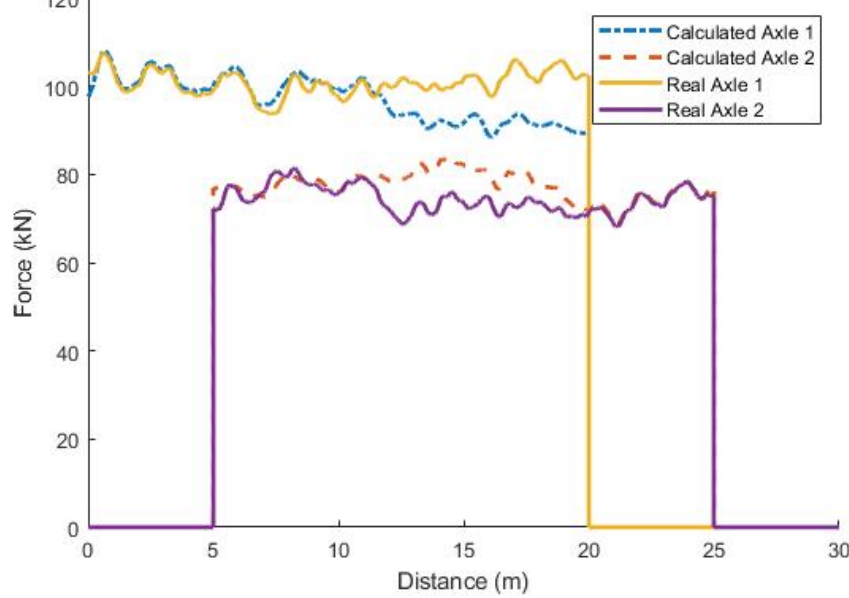
Figure 3. Actual and calculated force histories for baseline example with optimum λ .